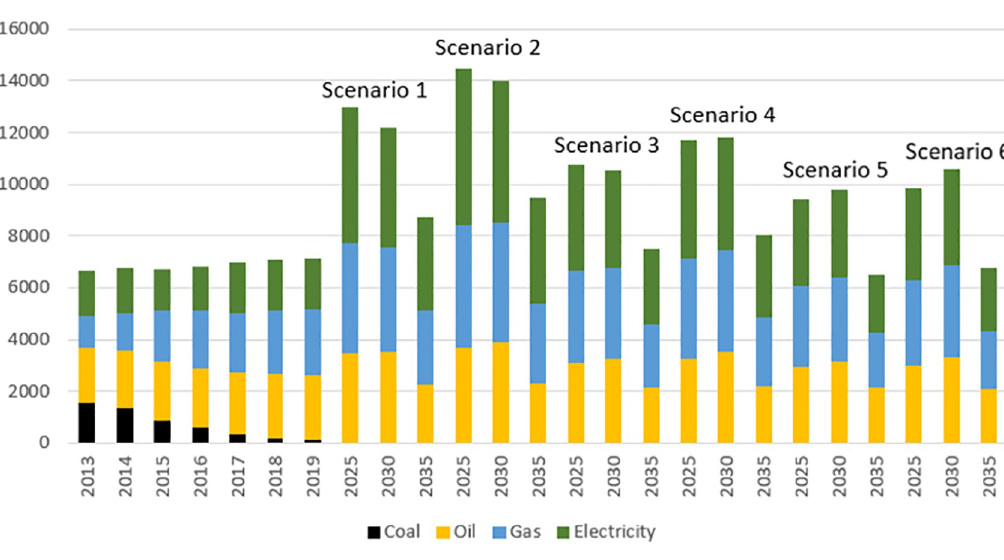
Fig 5. Forecast scenarios of energy consumption in